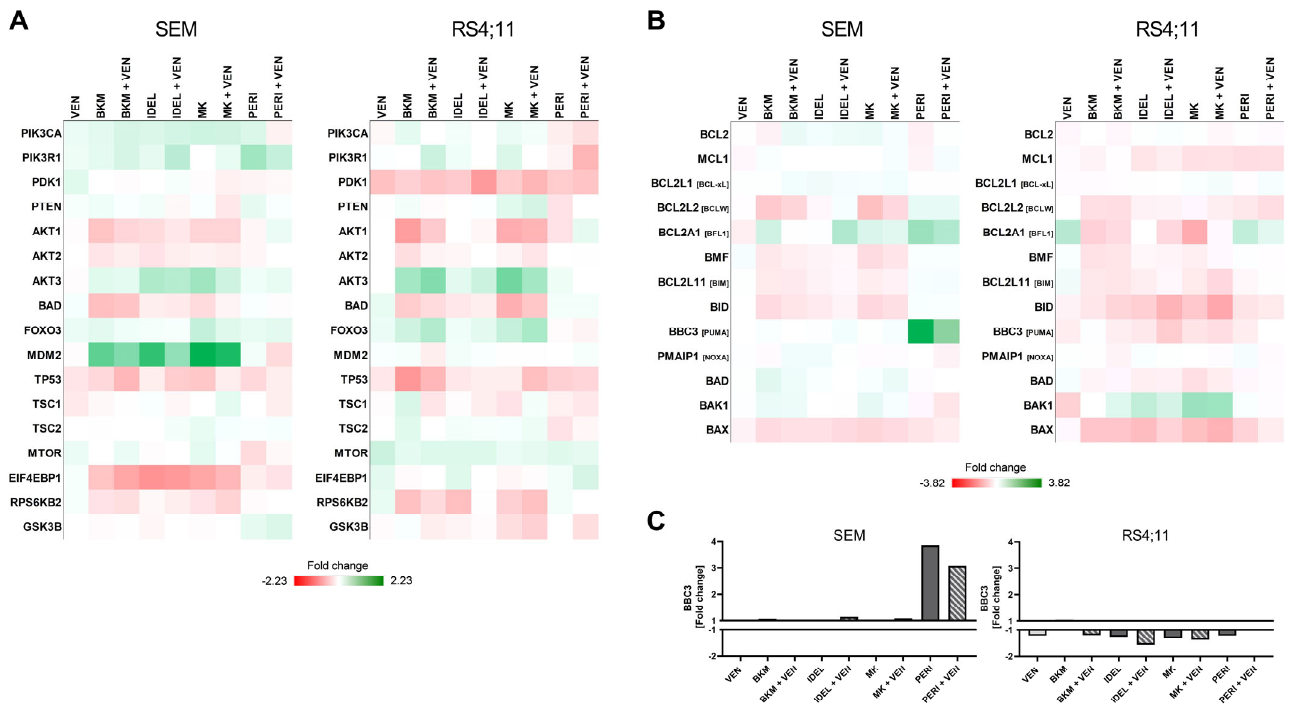
Figure 4. Analysis of PI3K/AKT and BCL-2 pathway gene expression via targeted RNA panel sequencing. ( A , B ) Heatmap of the PI3K/AKT ( A ) and BCL-2 ( B ) pathway gene expression. Fold change (FC) compared to control. Green and red colors represent up- and downregulation, respectively. ( C ) Bar graph of BBC3 fold change after treatment compared to control. FC values may be covered by the scale of the graph and are therefore additionally listed in Table S1.